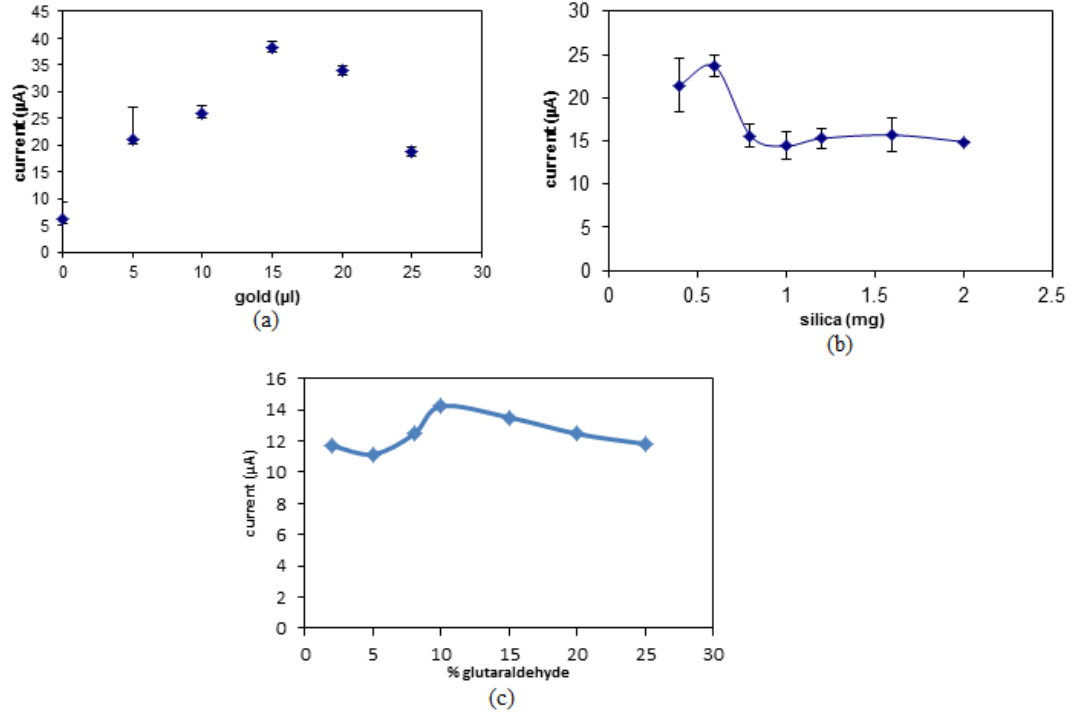
Figure 4. The optimization of the amount of ( a ) AuNPs, ( b ) SNs, and ( c ) glutaraldehyde linkers to be used for the biosensor.